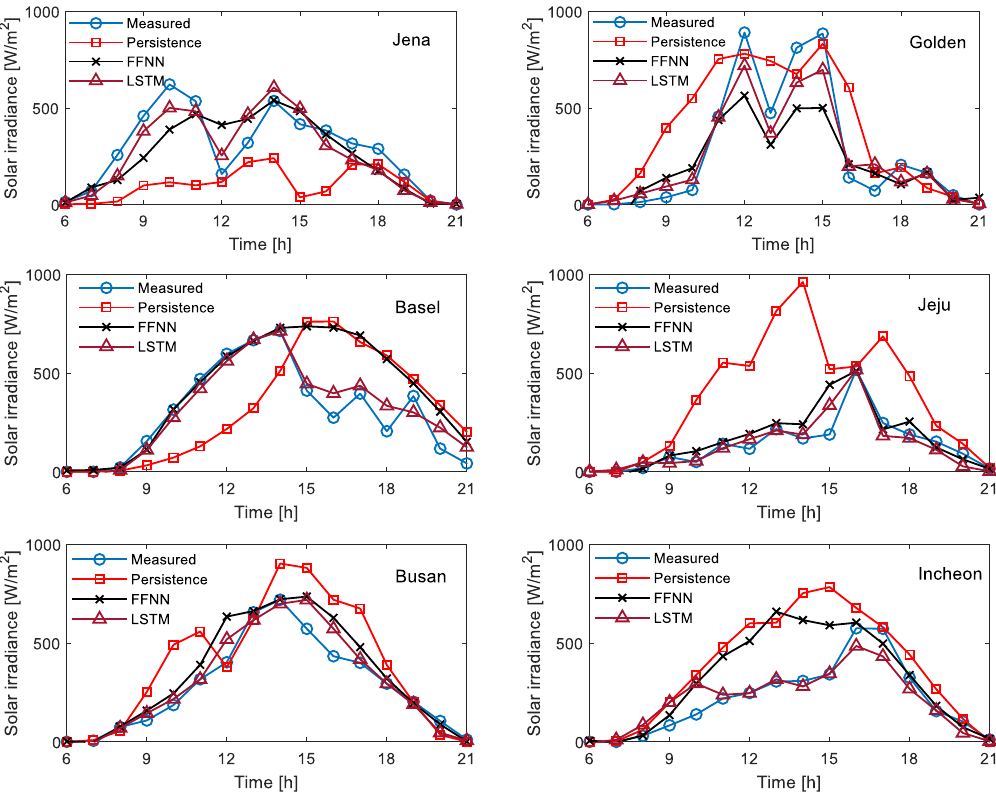
Figure 6. Measured and predicted solar irradiance for the proposed approach using LSTM, FFNN, and persistence model.